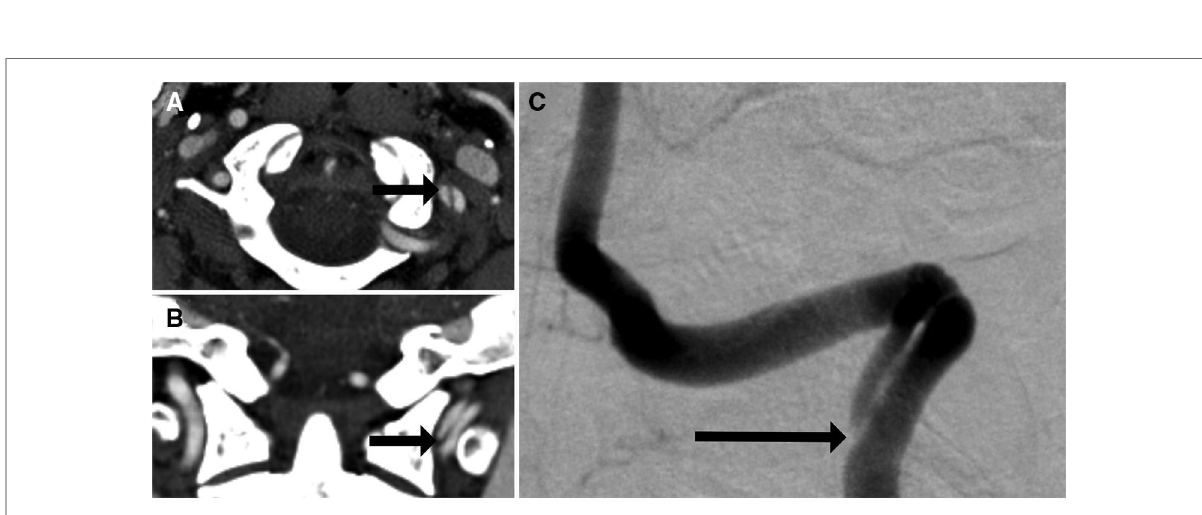
FIGURE 3 One-month follow-up imaging of the 35-year-old man shown in Figure 1 . Axial ( A ) and coronal ( B ) imaging showed interval development of a left vertebral artery dissection fl ap (arrows). This was con fi rmed on DSA ( C ) with the dissection fl ap beginning at the site of prior intimal disruption